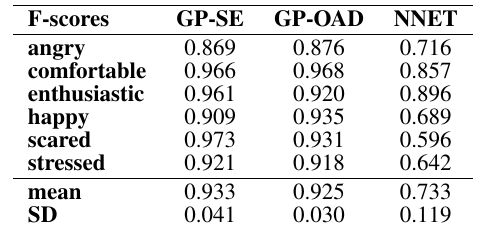
Table 1. Summary of F-scores using the different